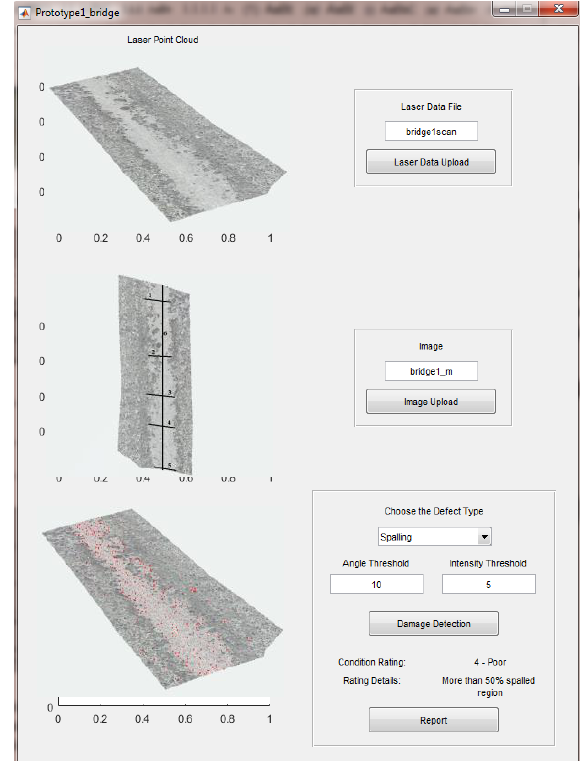
Figure 2: The texture-mapped point cloud of the Çayırhan Bridge.